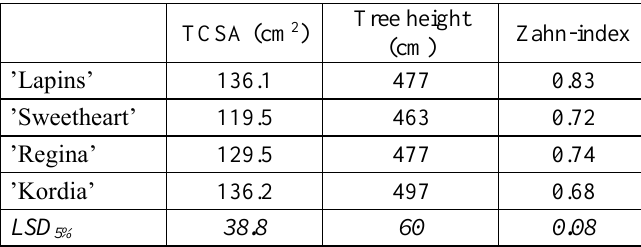
Table 2. Parameters related with tree size of five years old trees